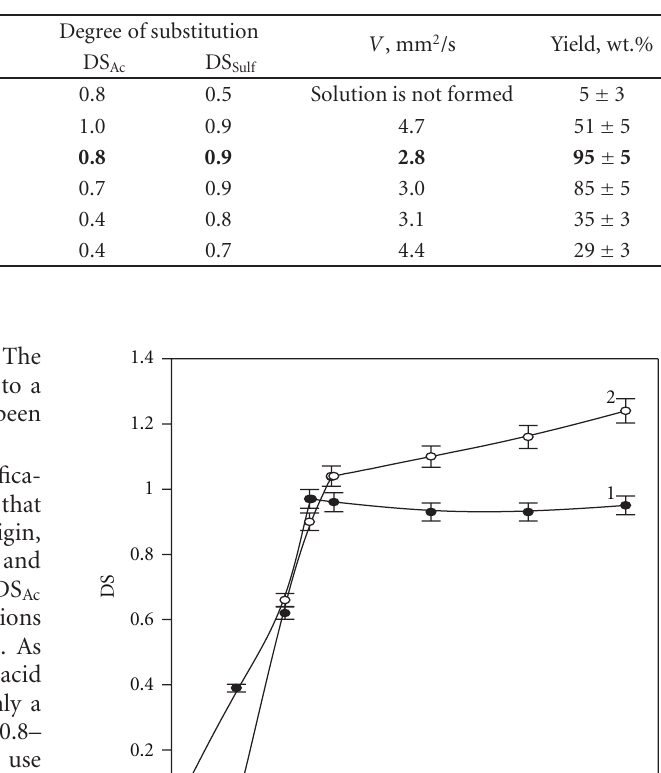
Table 1: E ff ect of the esterification mixture components volume ratio (AA/SA) on the main CAS characteristics.